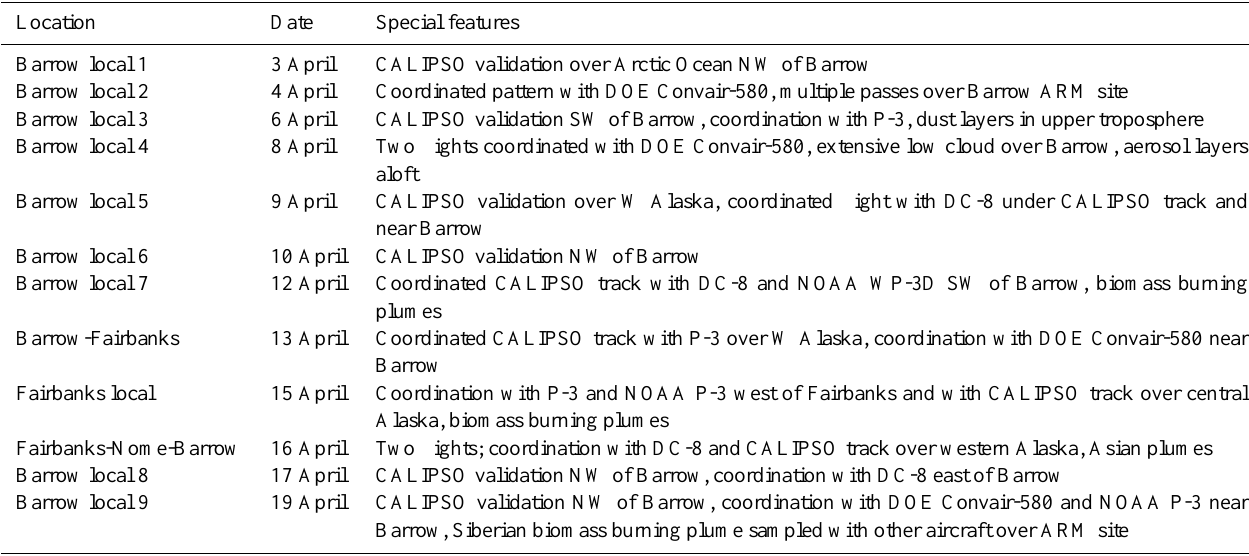
Table 4c. B-200 flights during the ARCTAS-A spring deployment 1 .